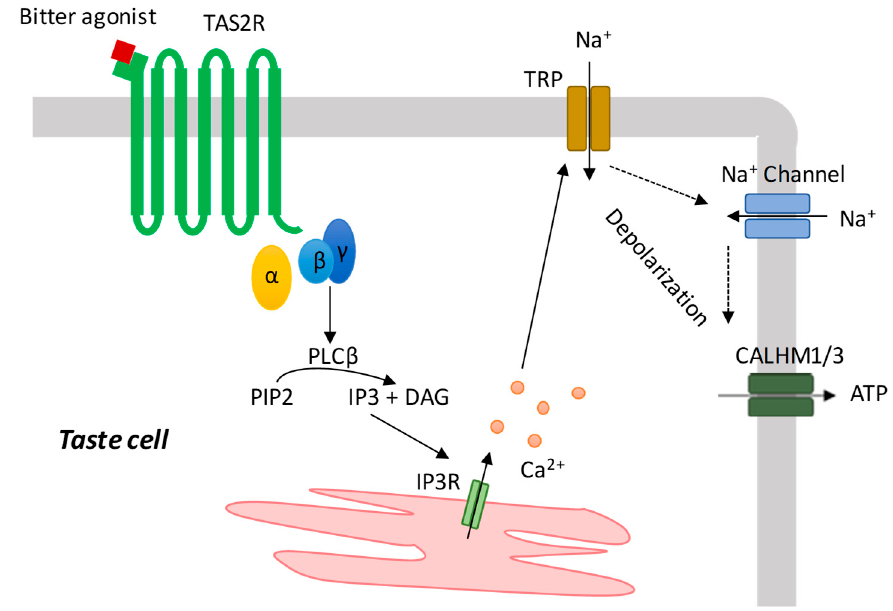
Figure 2. TAS2R signal transduction cascade in taste cells.